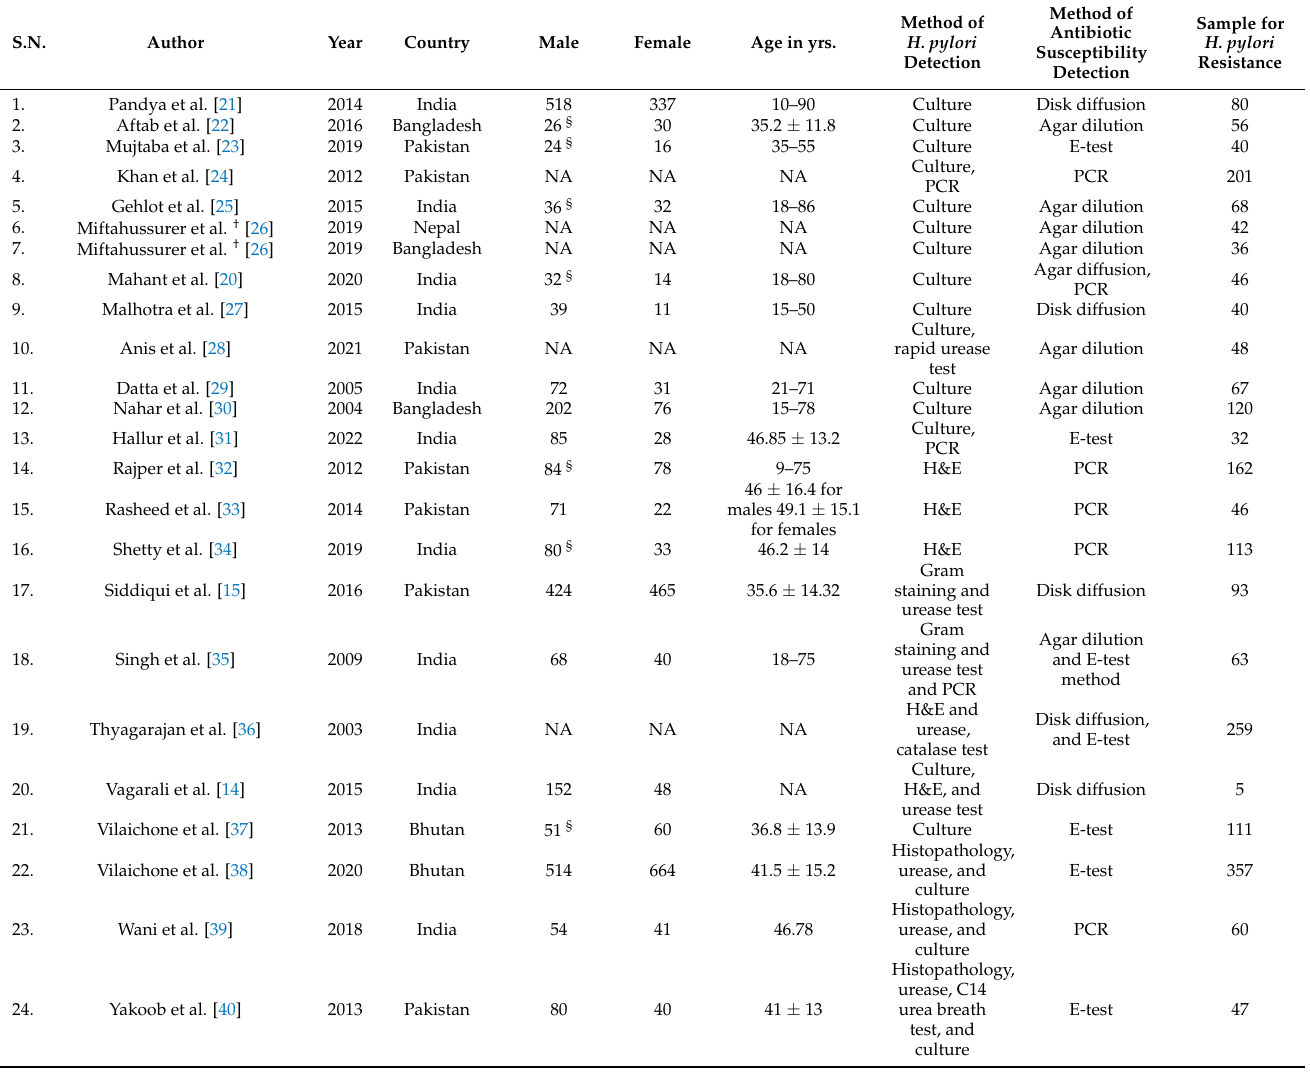
Table 1. Characteristics of the included